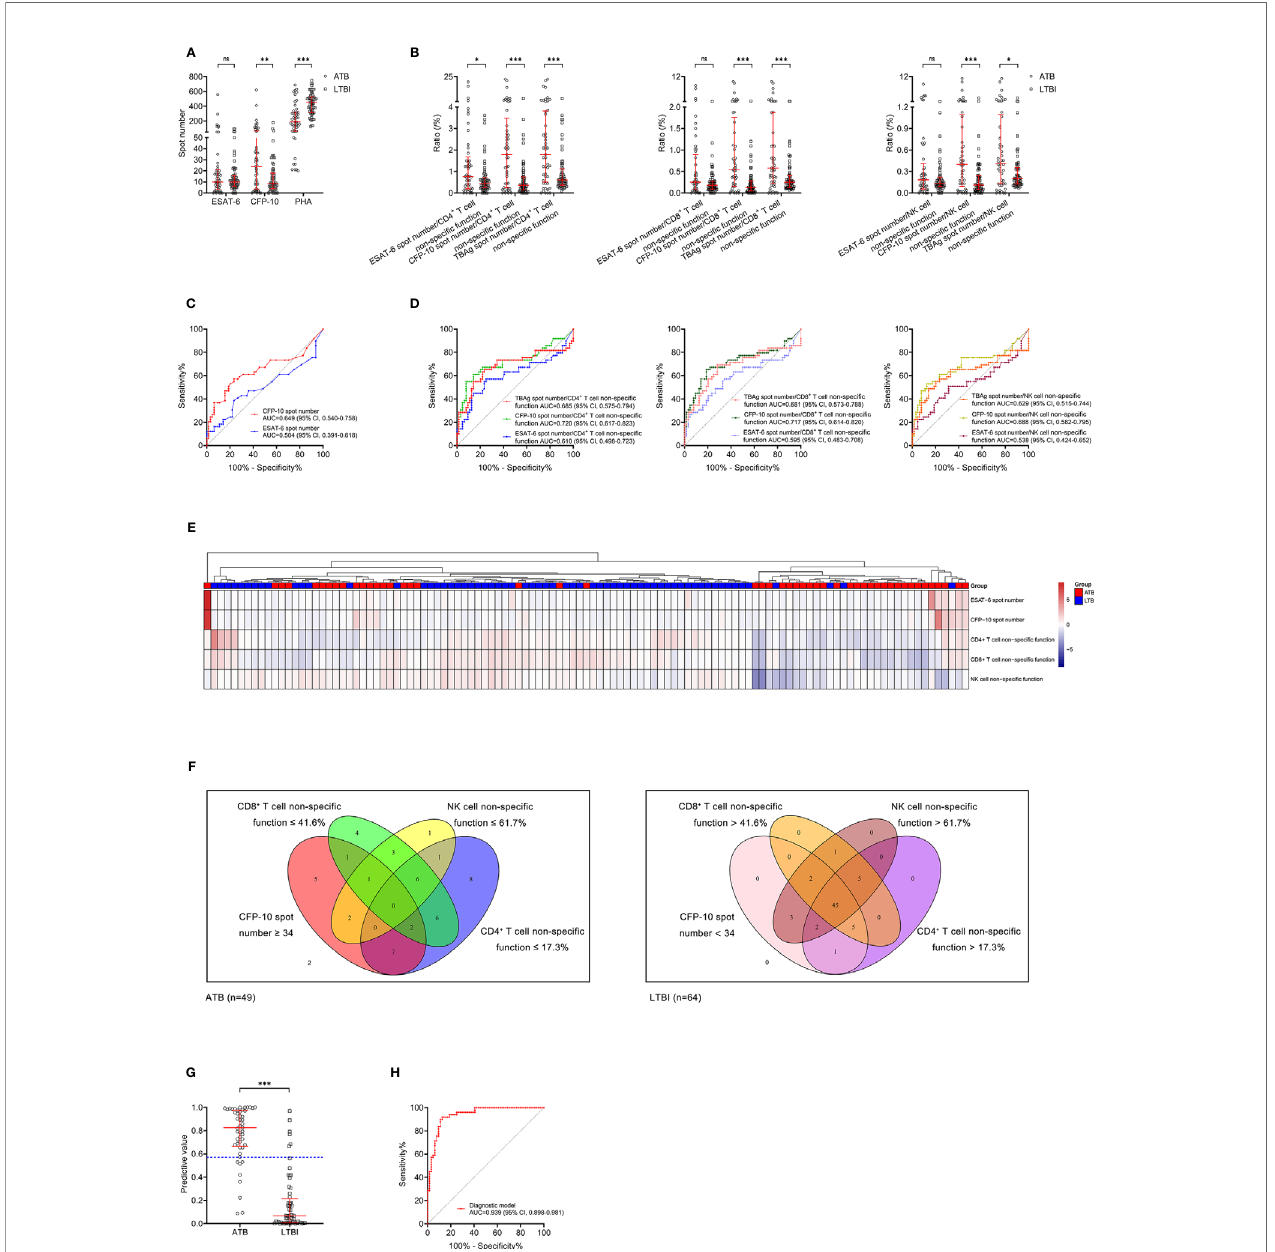
FIGURE 4 | Combination of lymphocyte non-speci fi c function and T-SPOT for differentiating ATB from LTBI. (A) Scatter plots showing the results of ESAT-6 spot number, CFP-10 spot number, and PHA spot number in ATB patients (n=49) and LTBI individuals (n=64). Bars indicated the medians and interquartile ranges. ** P < 0.01; *** P < 0.001; ns, no signi fi cance (Mann-Whitney U test). (B) Scatter plots showing the ratio of MTB-speci fi c antigen spot number/lymphocyte non- speci fi c function in ATB patients (n=49) and LTBI individuals (n=64). Bars indicated the medians and interquartile ranges. * P < 0.05; *** P < 0.001; ns, no signi fi cance (Mann-Whitney U test). (C) ROC analysis showing the performance of ESAT-6 spot number and CFP-10 spot number in discriminating ATB patients from LTBI individuals. (D) ROC analysis showing the performance of MTB-speci fi c antigen spot number/lymphocyte non-speci fi c function in discriminating ATB patients from LTBI individuals. (E) Heatmap showing the cluster analysis of lymphocyte non-speci fi c function and T-SPOT results in ATB patients (n=49) and LTBI individuals (n=64). Each rectangle indicates a result of a subject. (F) Venn diagrams showing the overlap of CD4 + T cell non-speci fi c function, CD8 + T cell non-speci fi c function, NK cell non-speci fi c function, and CFP-10 spot number in ATB patients (n=49) and LTBI individuals (n=64). (G) Scatter plots showing the predictive value of diagnostic model in ATB patients (n=49) and LTBI individuals (n=64). Bars indicated the medians and interquartile ranges. *** P <0.001 (Mann-Whitney U test). Blue dotted line indicates the cutoff value in distinguishing these two groups. (H) ROC analysis showing the performance of diagnostic model based on the combination of CD4+ T cell non-speci fi c function, NK cell non-speci fi c function, and CFP-10 spot number in discriminating ATB patients from LTBI individuals. ESAT-6, early secreted antigenic target 6; CFP-10, culture fi ltrate protein 10; PHA, phytohemagglutinin; MTB, Mycobacterium tuberculosis ; ATB, active tuberculosis; LTBI, latent tuberculosis infection; ROC, receiver operating characteristic; AUC, area under the curve; CI, con fi dence